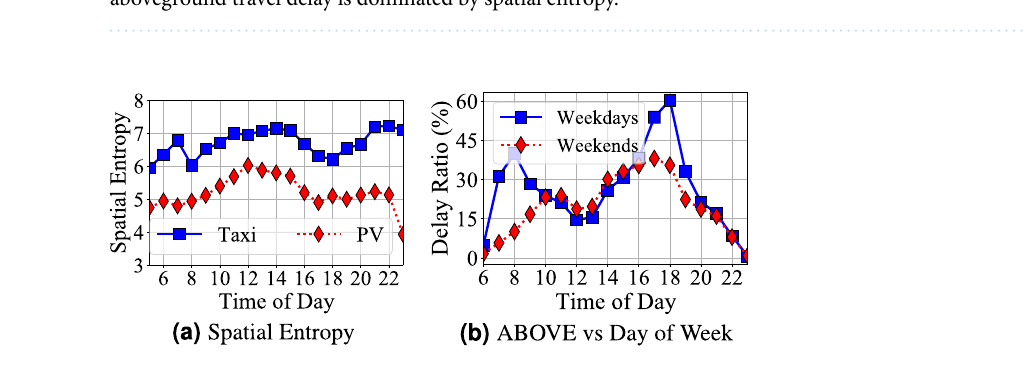
Figure 9. ( a ) A lower spatial entropy means lower randomness on spatial dimension and cars moves to certain areas; ( b ) lower peak hour and shifts on